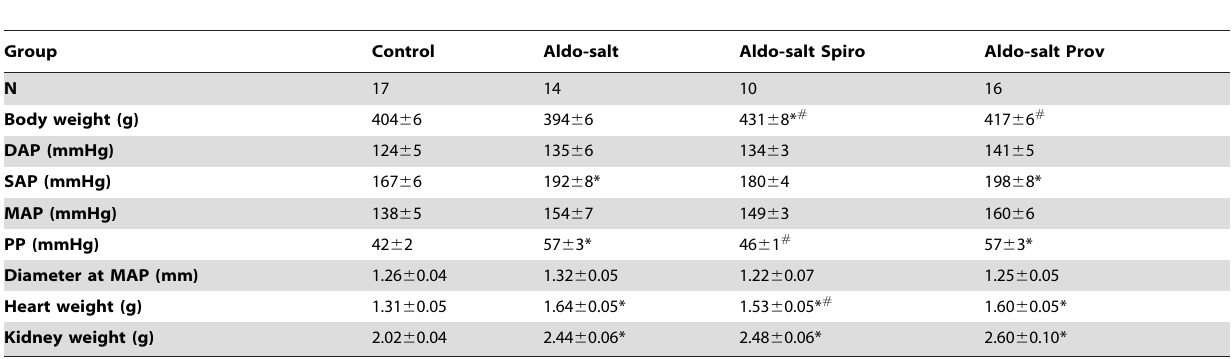
Table 1. Effects of treatment by spironolactone (Spiro) or Provinols TM (Prov) on blood pressure, carotid diameter and organ weights in aldosterone-salt (Aldo-salt) treated rats.